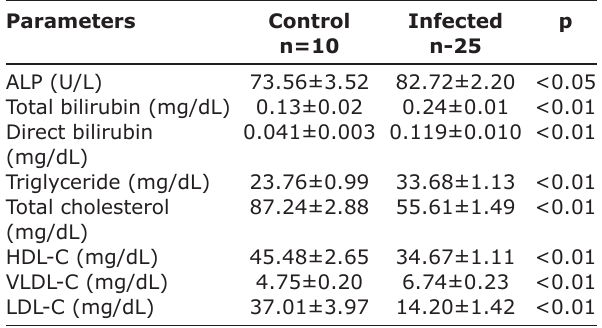
Table-1: Mean and the standard error of the mean (x¯±SE) values for ALP, direct and total bilirubin, triglycerides, total cholesterol, HDL-C, VLDL-C and LDL-C of neonatal calves with